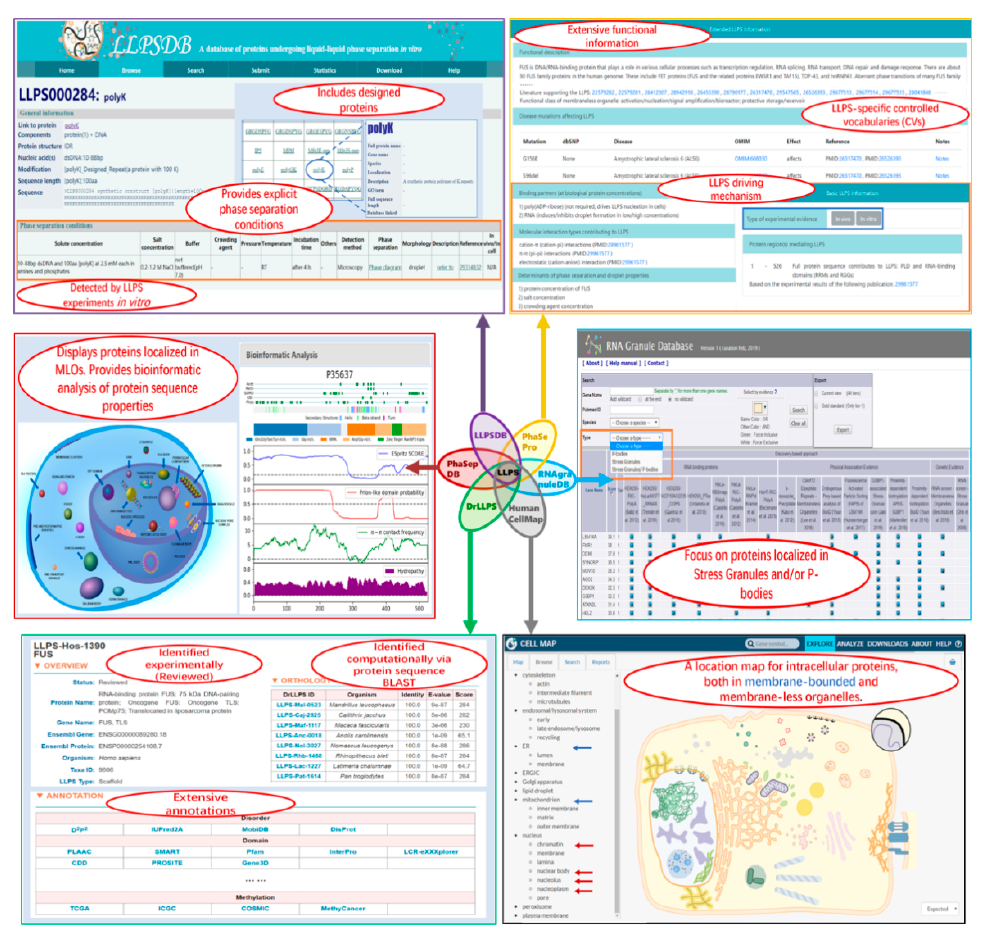
Figure 2. Screenshots of some webpages of the six related databases. In each squared screenshot, the unique features of the corresponding database are shown in red font text within the ellipse region(s).